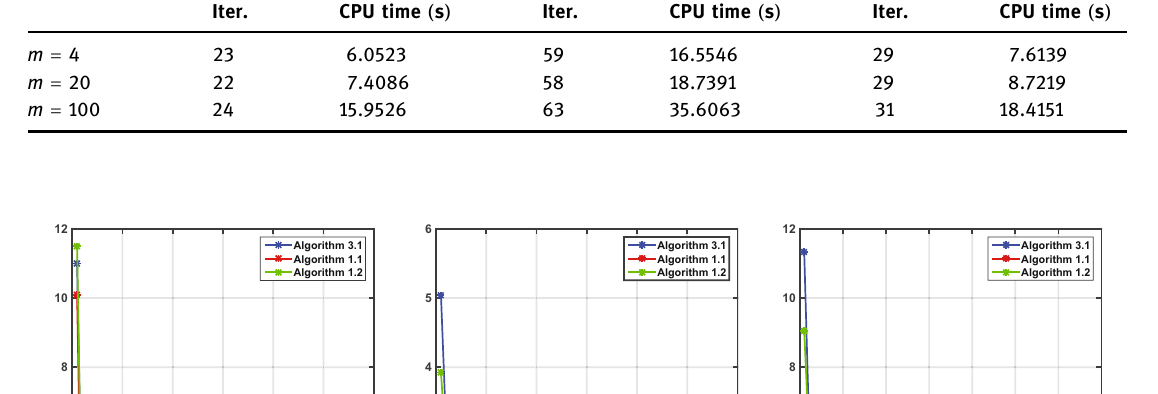
Algorithm 3.1 Algorithm 1.1 Algorithm 1.2